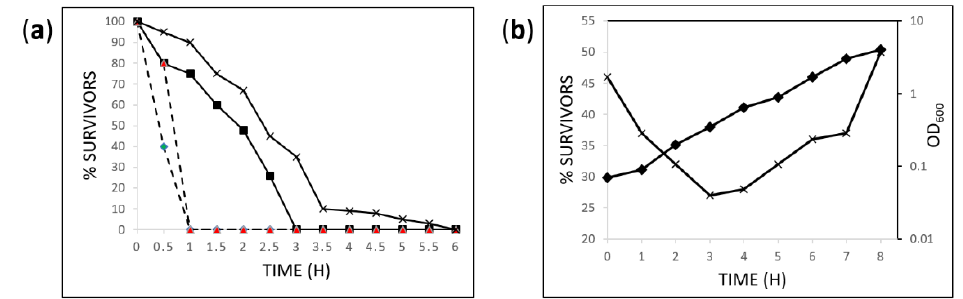
Figure 1. Acid resistance and impact of growth phase on resistance. Panel ( a ): overnight MRS cultures of L. acidophilus ATCC 4356 ( ♦ and ■ ) and L. paracasei GCRL 46 ( ▲ and X ) were diluted into MRS at pH 2 (dashed lines) or 2.5 (solid lines) and viable counts determined every 30 min to determine % survivors relative to time zero. Panel ( b ): strain GCRL 46 was cultured in fermenters without pH control, growth monitored by OD 600 ( ♦ ) and samples taken after inoculation then hourly to determine % survivors ( X ) after 2 h in MRS broth at pH 2.5.